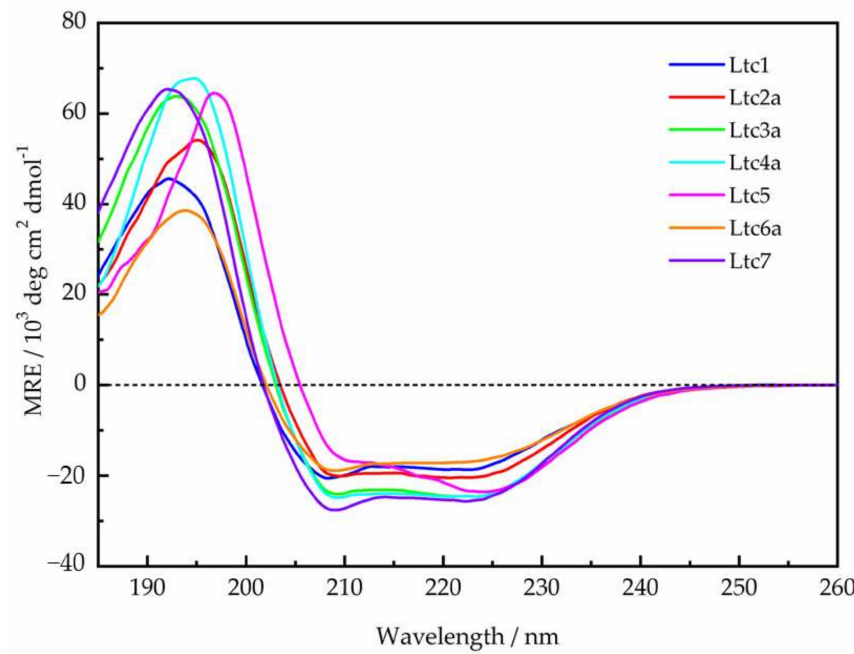
Figure 2. Circular dichroism spectra of latarcins in the presence of small unilamellar vesicles made from DMPC/DMPG (7/3) measured at a molar peptide-to-lipid ratio (P/L) of 1/50 at 30 ◦